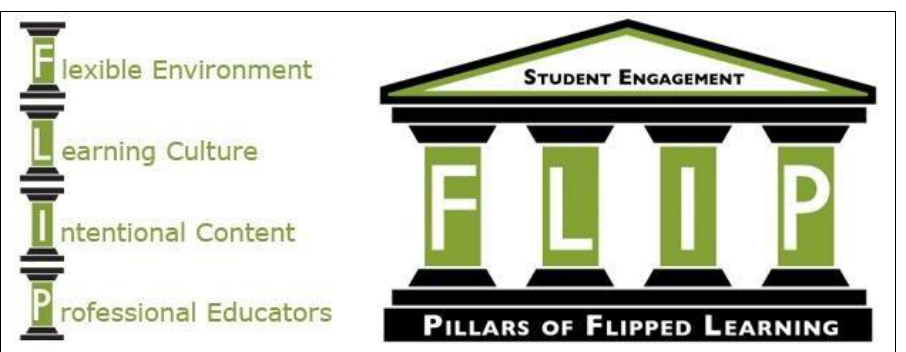
Figure 2 . The pillars of flipped learning (Rahman & Hashim,